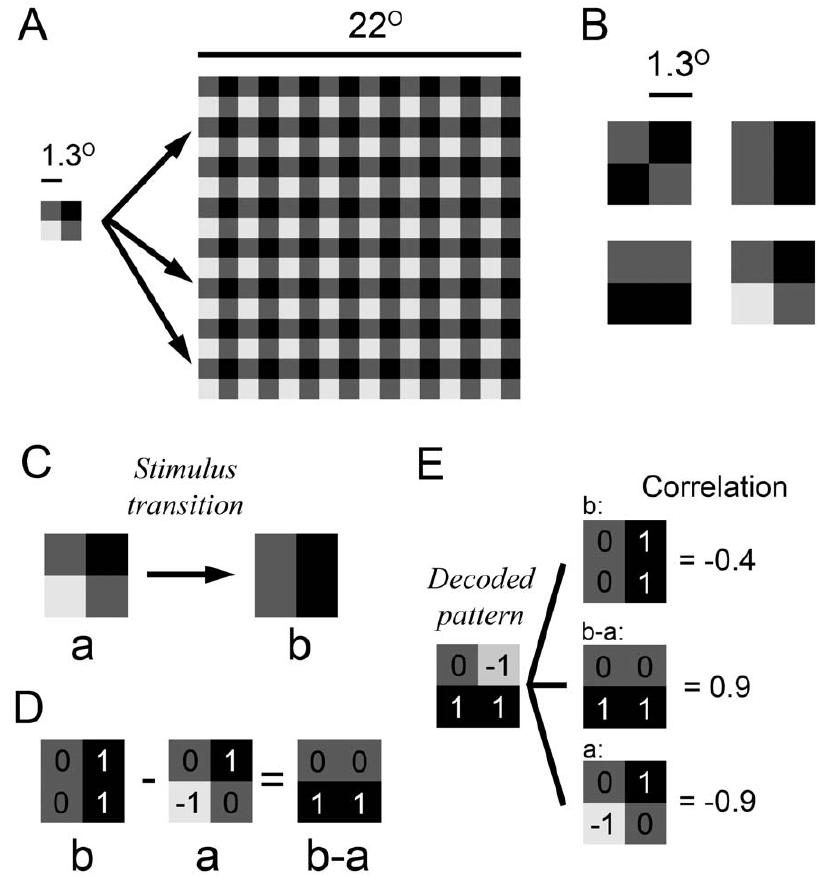
Figure 1. Visual stimuli used in this study. A: All stimulus patterns used in this study were covering 22 6 22 u of the visual field. A luminance pattern consisting of 2 6 2 squares (each square was 1.3 u ) was repeated 8 6 8 times in order to cover the 22 6 22 u screen area. B: Four examples of the 81 different patterns. C: An example of a stimulus transition. D: Calculating the difference pattern for the stimulus transition shown in C. E: The decoded pattern was correlated with the previous pattern, the current pattern and the difference pattern.